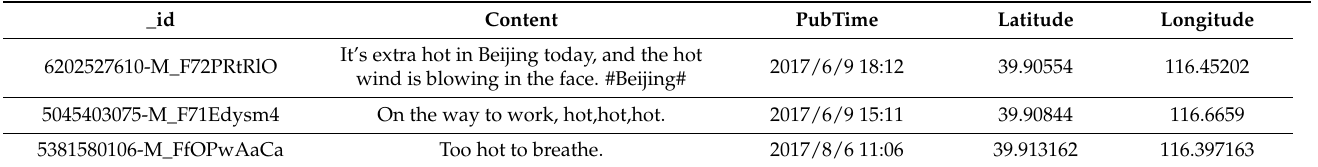
Table 1. Sample of the main Weibo data.